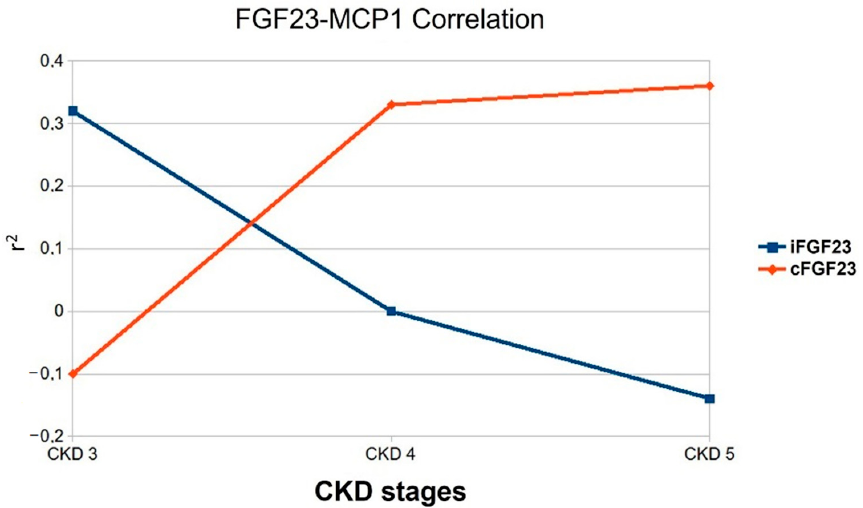
Figure 4. Correlation between MCP1 and i/cFGF23 during CKD stages 3, 4, and 5. Two-tailed Spear- man bivariate analysis. n = 19 in CKD3, n = 25 in CKD4, n = 12 in CKD5. Spearman bivariate analysis. n = 19 in CKD3, n = 25 in CKD4, n = 12 in